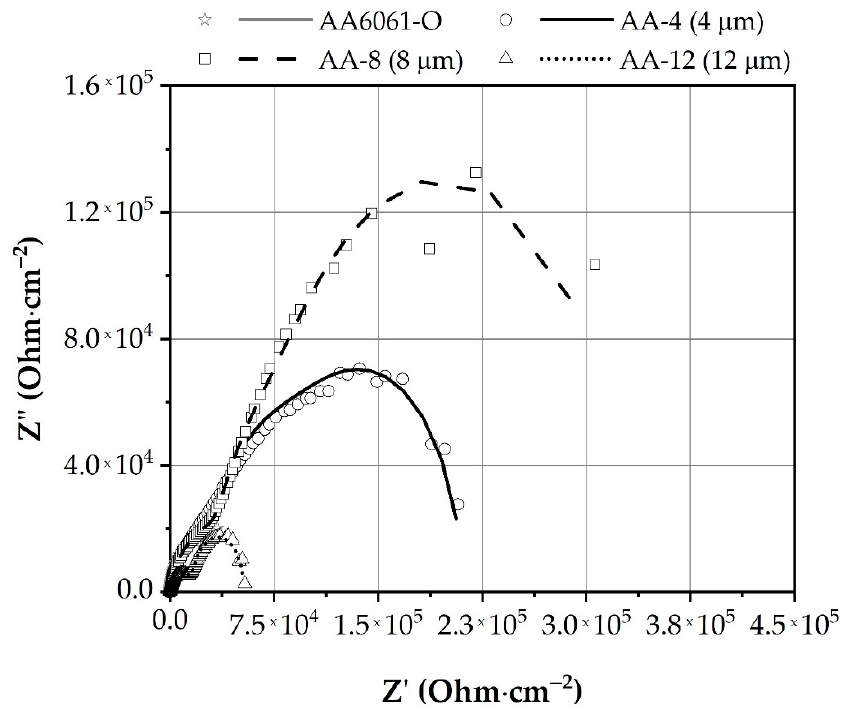
Figure 5. Experimental electrochemical Nyquist impedance spectra in the complex plane.